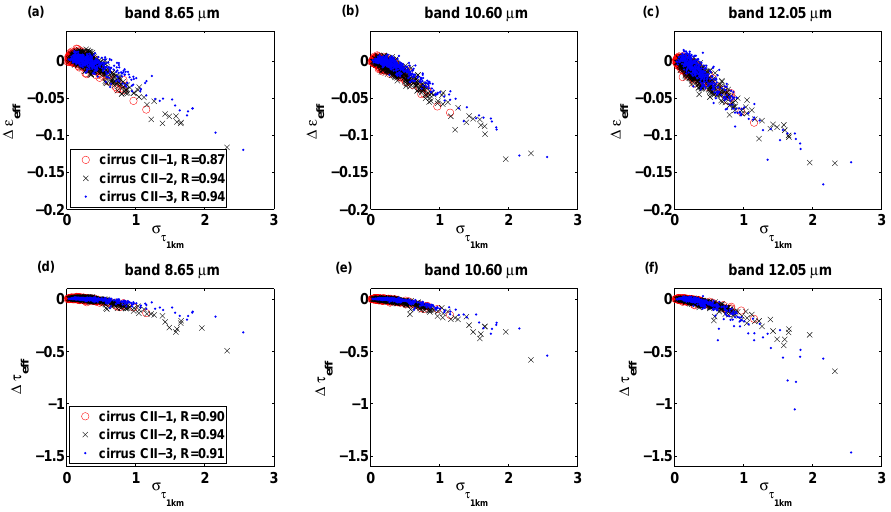
Figure 9. Errors on the effective emissivity (cid:49)ε eff ( a , b and c ) and on the effective optical thickness (cid:49)τ eff ( d , e and f ) at 8.65, 10.60 and 12.05µm, respectively, as a function of the optical thickness standard deviation, σ τ